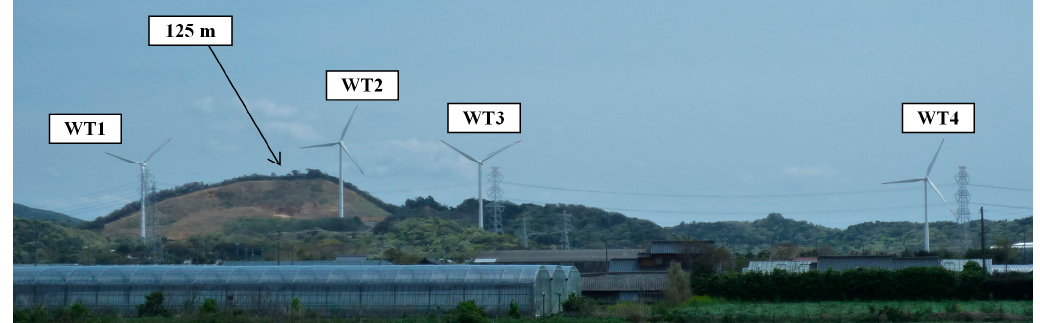
Figure 2. A photo of the wind turbine site (taken by one of the authors from the north-west). Note: Minor landforms of 125 m in elevation can be seen behind WT2 (Wind Turbine 2).